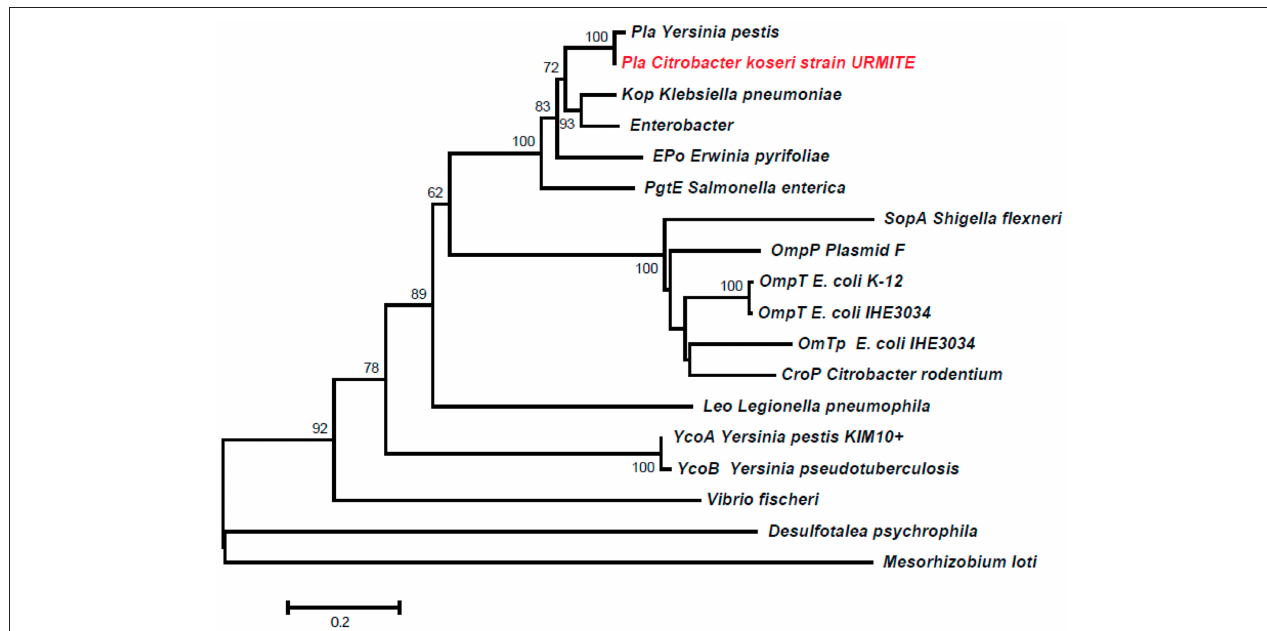
FIGURE 7 | Phylogeny inference of the main members of the omptin family including the predicted Pla protein of pCitro1. The phylogeny of the omptin family indicated that our predicted Pla protein is closely related to that of Y. pestis .